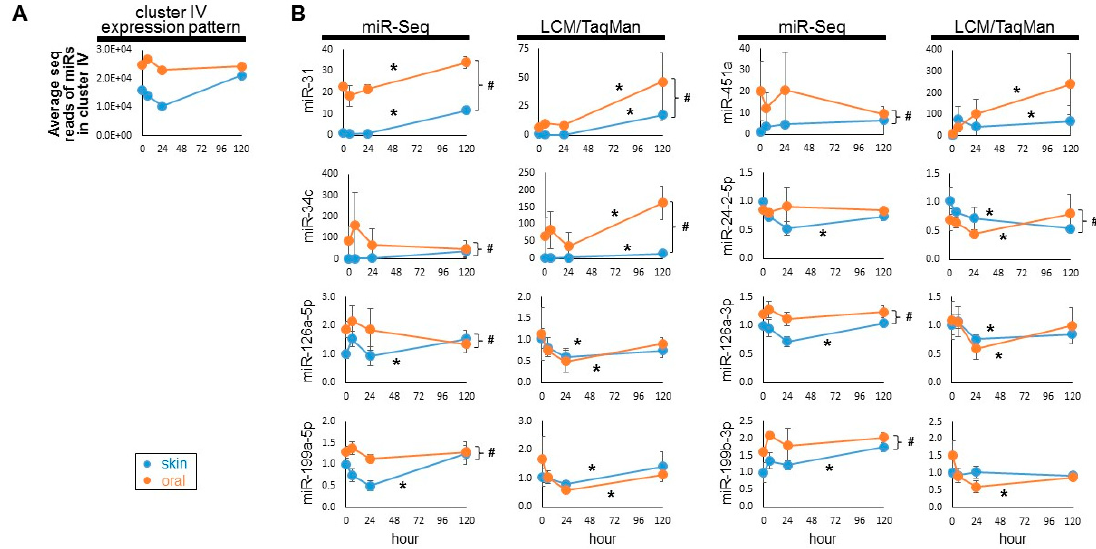
Figure 2. Validation of the differentially expressed microRNAs in Cluster IV. ( A ) The general expression pattern of Cluster IV over the time course of skin and oral mucosal wound is shown as the average of the mapped sequence reads of the microRNAs in the cluster. ( B ) LCM isolated epithelial cells from the wound edges were procured from the paired skin and oral mucosa murine wound-healing model, at 0 h, 6 h, 24 h and 5 days post-wounding (n ≥ 4). The levels of individual Cluster IV microRNAs (mmu-miR-31-5p, mmu-miR-451a, mmu-miR-34c-5p, mmu-miR-24-2-5p, mmu-miR-126a-5p, mmu-miR-126a-3p, mmu-miR-199a-5p, mmu-miR-199b-3p) were assessed by TaqMan assay-based real time PCR quantification (in duplicates). Expression patterns were compared with the relative levels of these microRNAs measured previously by miR-seq [10]. * indicates one-way ANOVA test p -value < 0.05 (within series comparison); # indicates two-way ANOVA test p -value < 0.05 (between series comparison). Statistical analyses are presented in Supplementary Table S4.